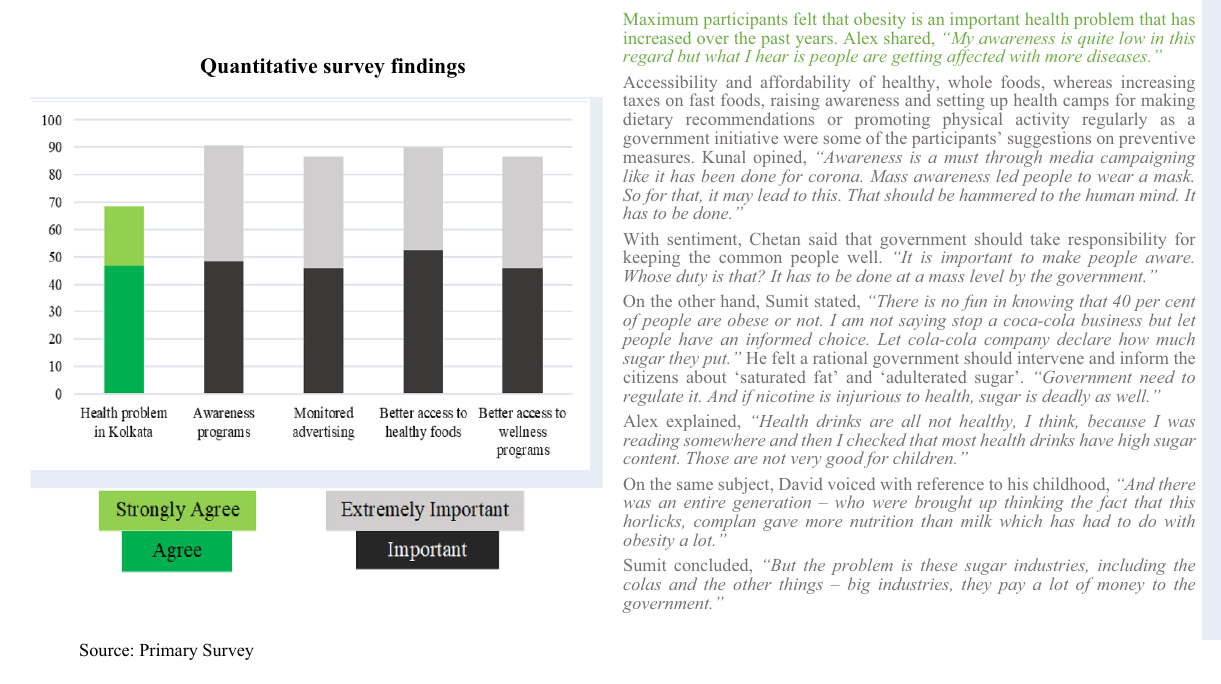
Qualitative interview findings